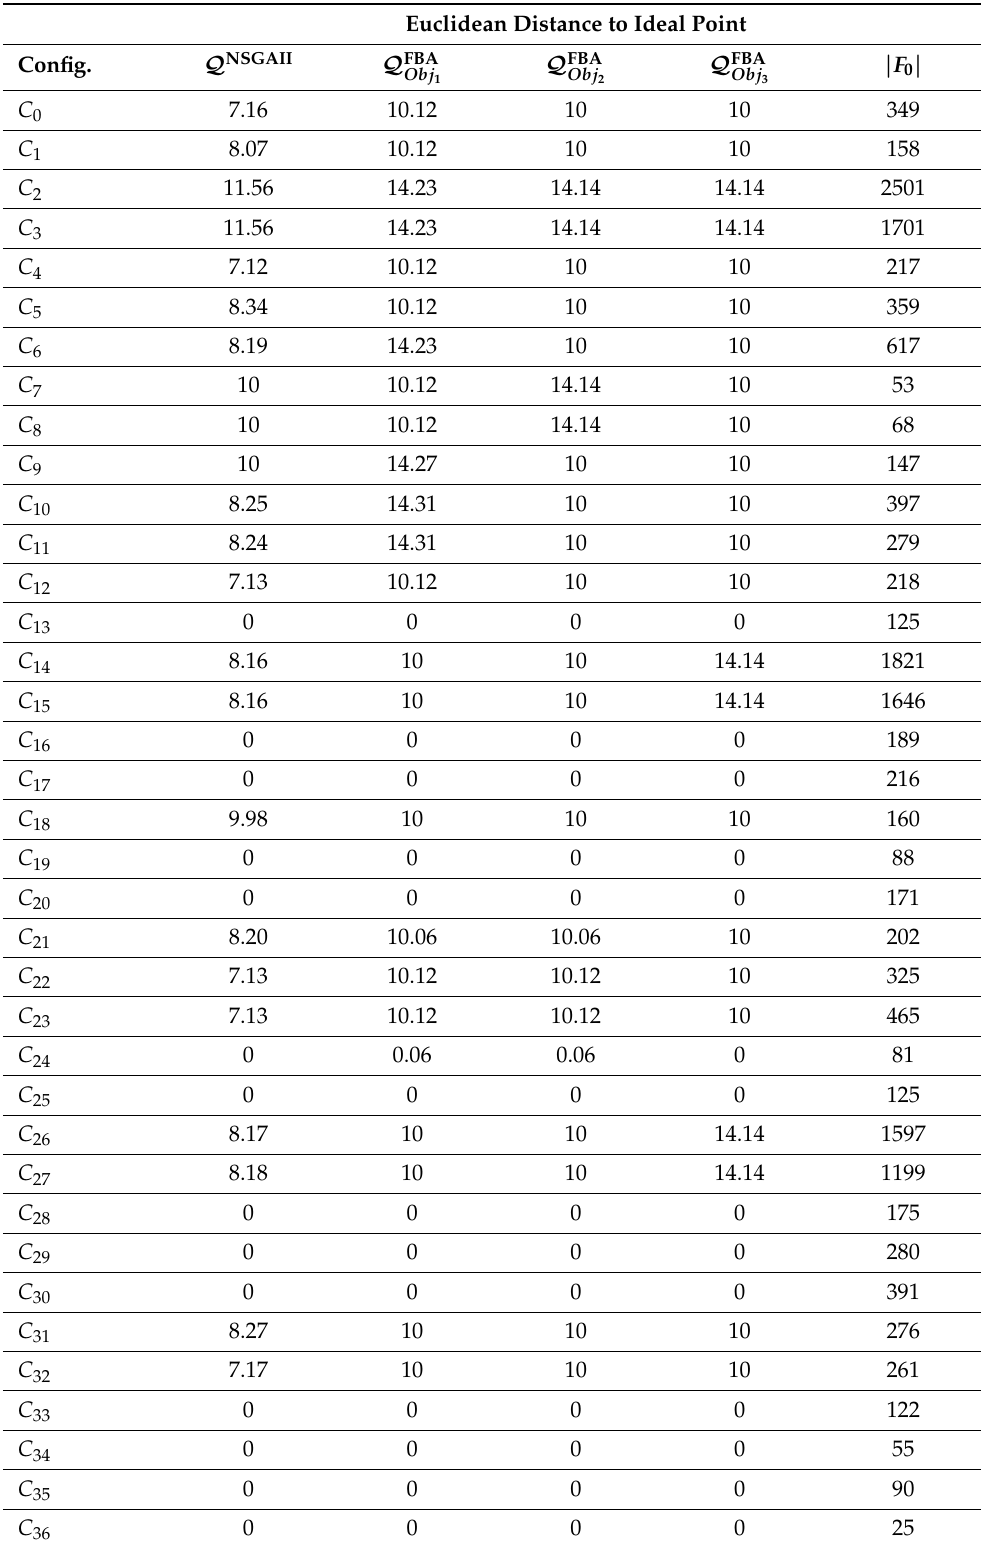
respectively. These results mean a rejection of H 0 , indicating a difference between the quality results of NSGAII and FBA, favoring NSGAII due to its lower values. Table 1. Report on best Euclidean distances to the ideal